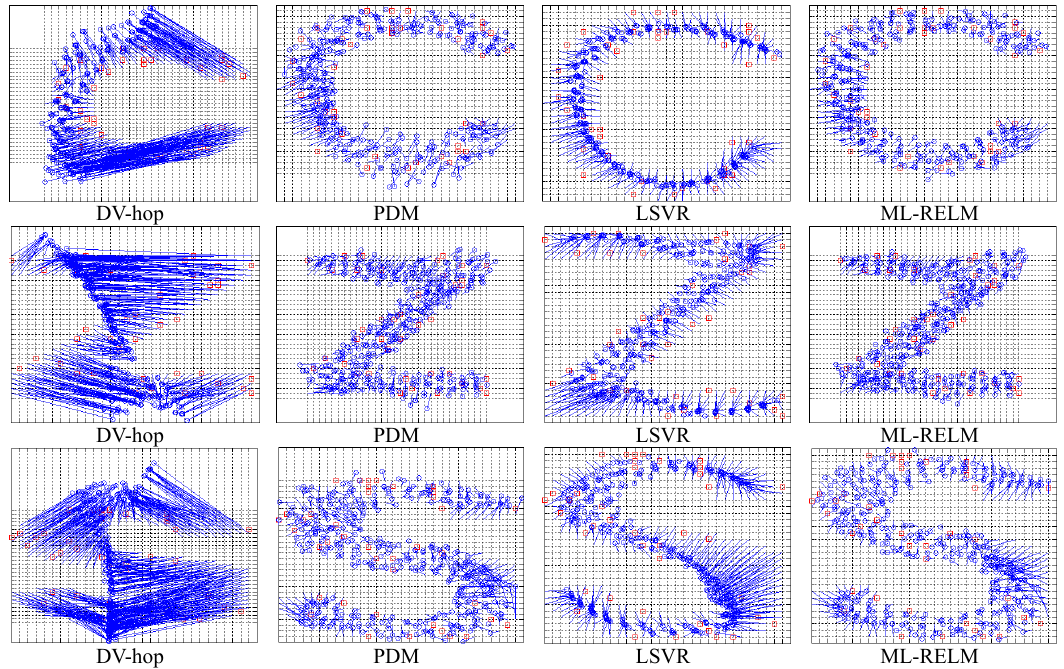
Figure 6. The localization results of regularly distributed nodes.